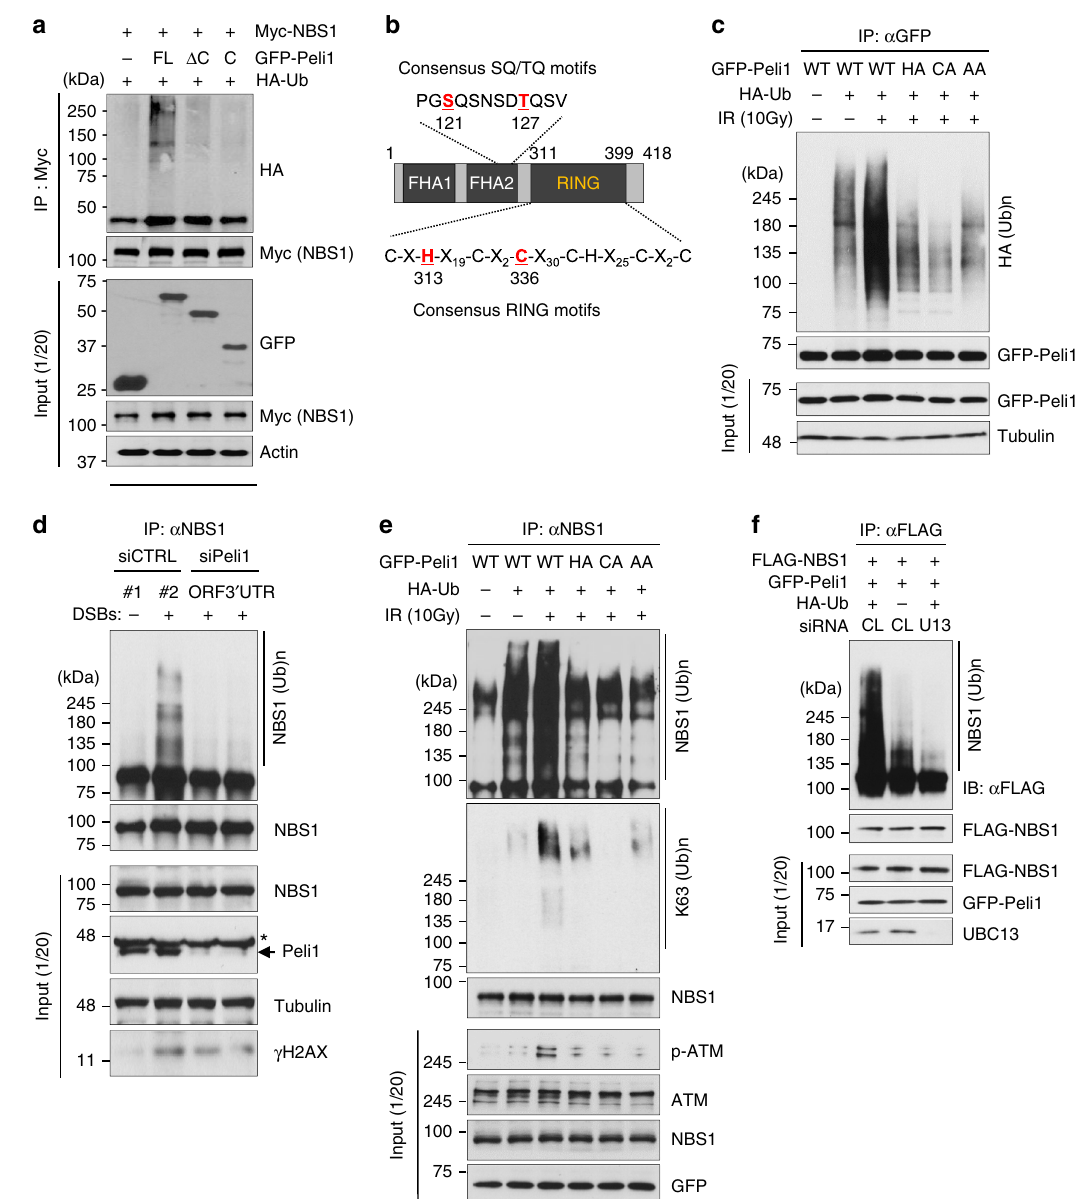
Fig. 6 Phosphorylation-mediated Peli1 activates NBS1 ubiquitination in vivo. a 293T cells were transfected with GFP-Peli1 WT, GFP-Peli1 C-terminal deletion, or C-terminal mutant in combination with HA-Ub and Myc-NBS1. At 36 h post transfection, cells were collected and immunoprecipitated with an anti-Myc antibody. NBS1 protein complexes were subjected to immunoblotting with anti-HA and anti-Myc antibodies. b Diagram of consensus motifs of SQ/TQ and RING domain of Peli1 protein in eukaryotes. c 293T cells were transfected with GFP-Peli1 WT, H313A (HA), C336A (CA), or S121A/T127A (AA) together with HA-Ub. At 48 h, cells were treated with IR. Cell lysates were immunoprecipitated with anti-GFP antibody. Autoubiquitination of GFP- Peli1 constructs was detected with anti-HA antibody. d , e K63-linked ubiquitination of NBS1 by Peli1. siRNA-targeting Peli1 ( d ) and plasmid encoding GFP- Peli1 ( e ) were transfected into 293T cells, respectively. Cell lysates were immunoprecipitated with anti-NBS1 antibody. NBS1 ubiquitination was detected by anti-NBS1-, anti-HA-, and K63-speci fi c antibodies. f 293T cells were transfected with GFP-Peli1, FLAG-NBS1, and HA-Ub. At 24 h post transfection, siRNAs targeting UBC13 #1 and #2 (U13), or control (CL) was reintroduced into cells. After 48 h, cells were immunoprecipitated with anti-FLAG antibody.